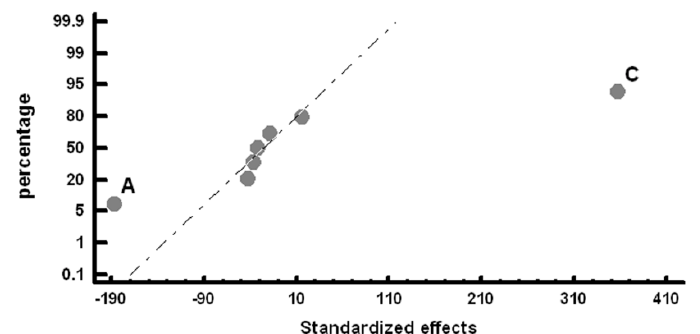
Figure 2. Standardized effects on the hardness of the matrix, on a normal probability plot.